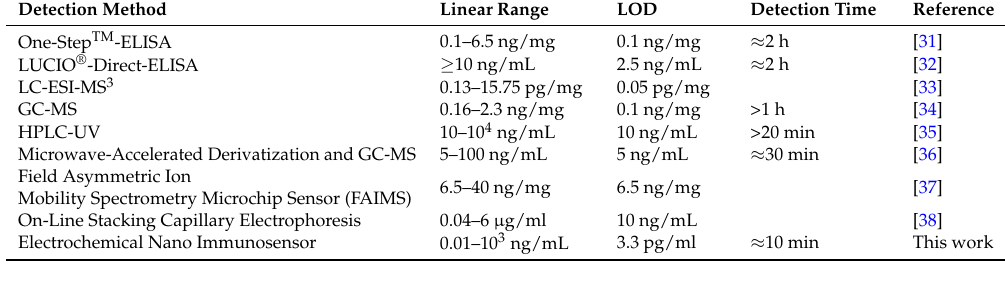
Table 1. Comparison of the performances of some different THC detection methods.